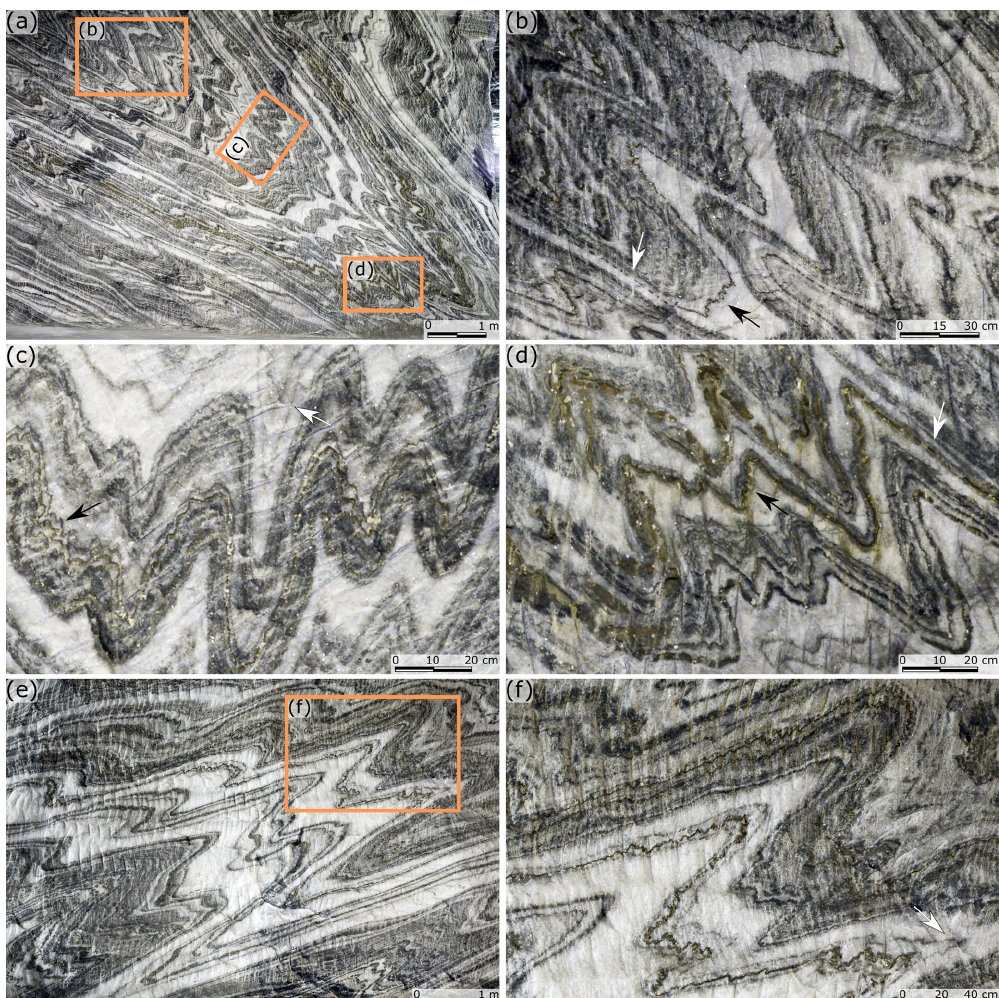
Figure 4. Photos of the eastern and western sides of pillar C50, illustrating different scale folding and the range of fold shapes. Note that the layers in the fold limbs are locally boudinaged (indicated with white arrows in b and d ). See text for further